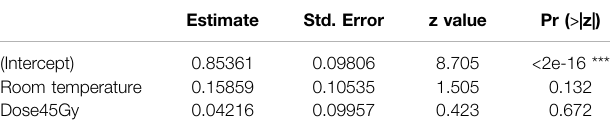
TABLE 2 | Fixed effects of chilling and irradiation on fl ight ability in Aedes albopictus males . Estimate Std. Error